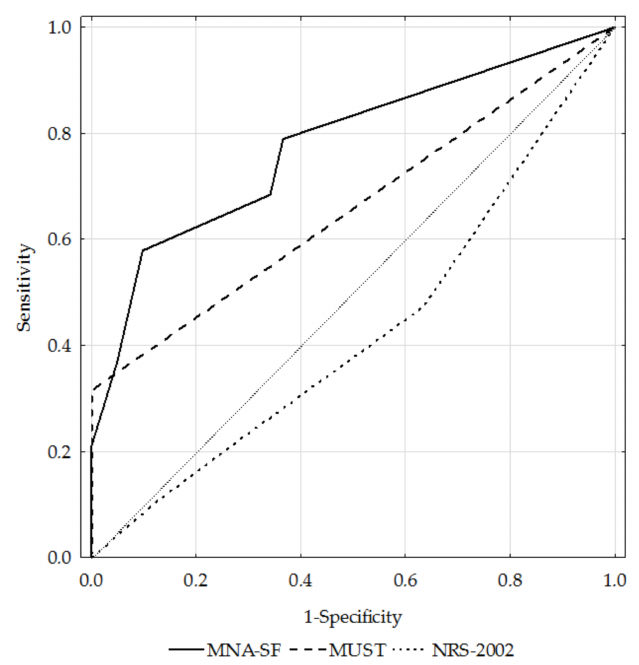
Figure 5. ROC curves for the MNA-SF, MUST, and NRS-2002 questionnaires against the GLIM criteria in the GOLD1+2 subgroup. Notes: MNA-SF, Mini Nutritional Assessment—Short Form; MUST, Malnutrition Universal Screening Tool; NRS-2002, Nutritional Risk Score; GLIM, Global Leadership Initiative on Malnutrition; GOLD, Global Initiative for Chronic Obstructive Lung